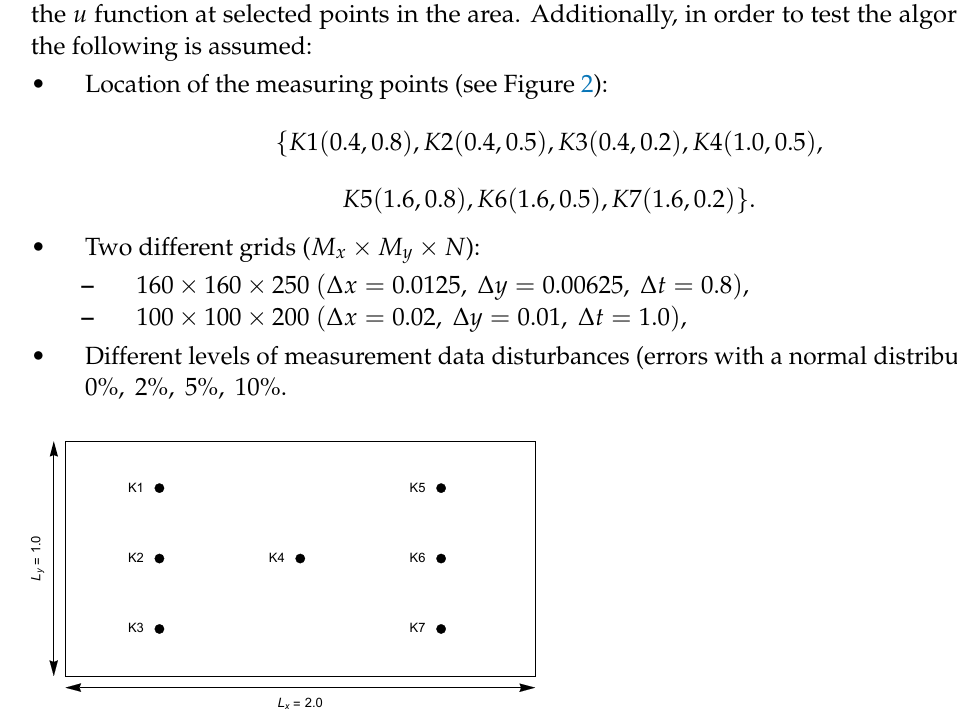
Figure 2. Arrangements of measuring